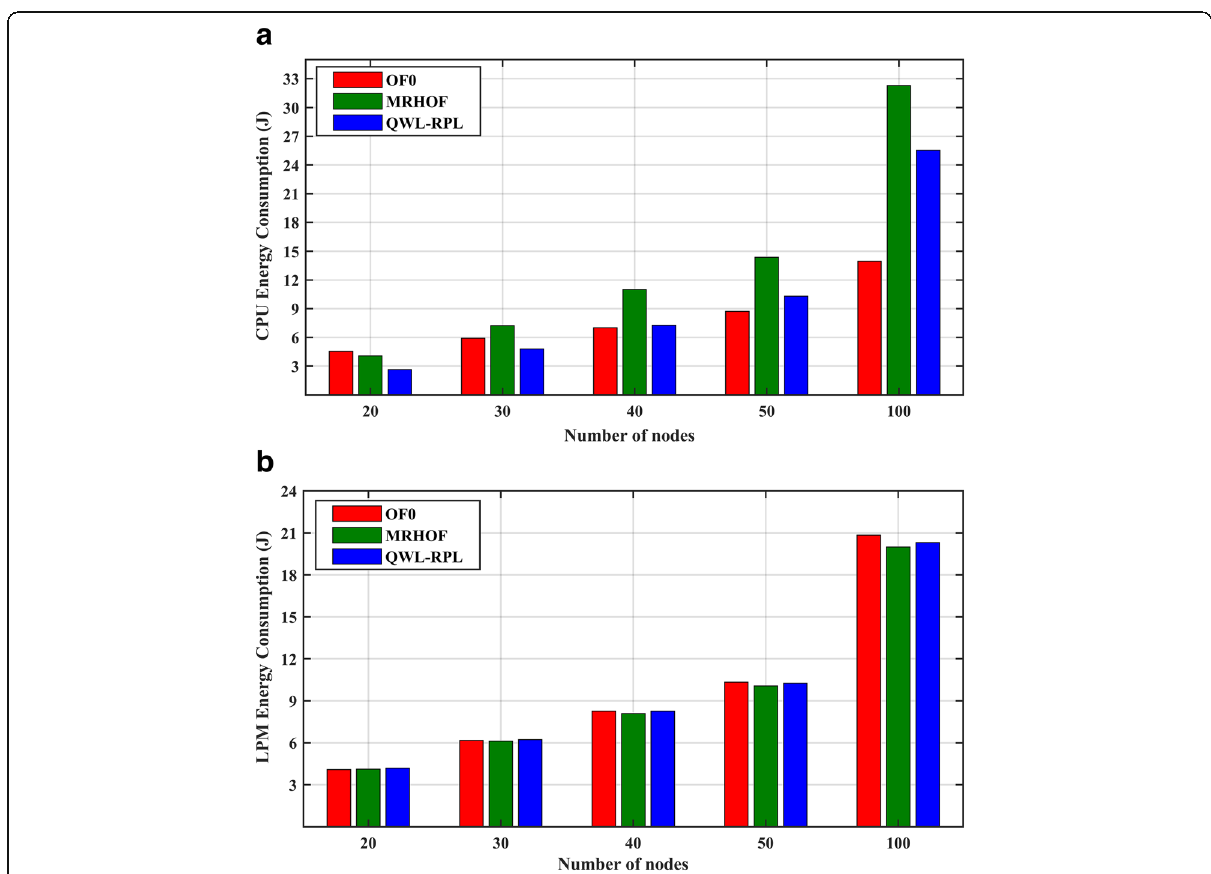
Fig. 16 Simulation analysis for scenario I for a CPU energy consumption (J) and b LPM energy consumption versus number of